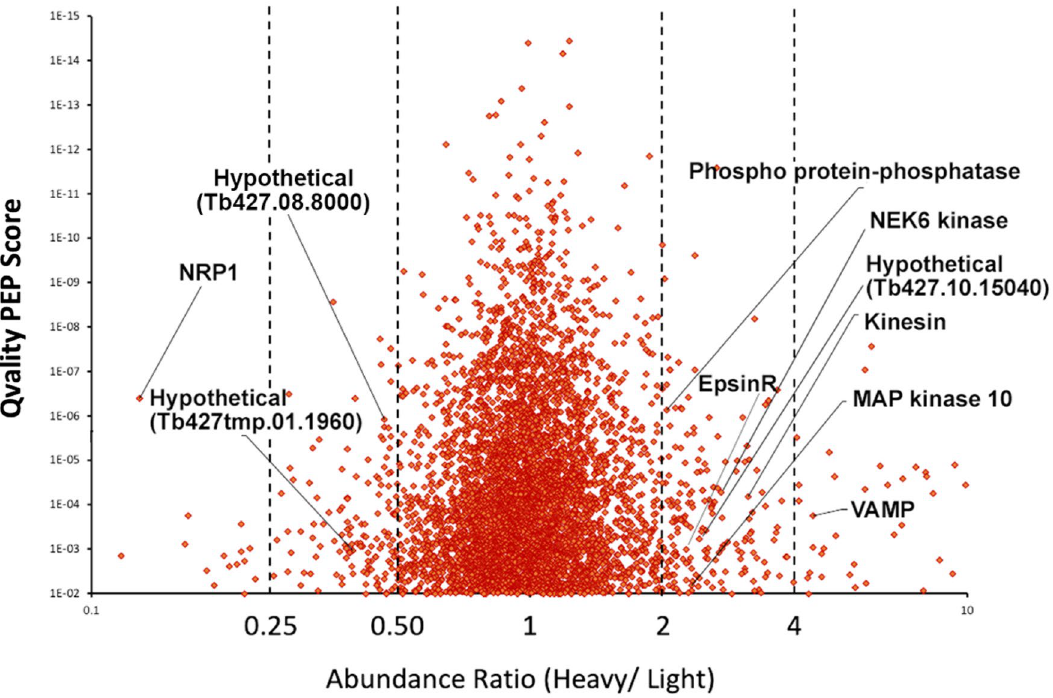
Figure 6. Knockdown of TbNRP1 alters phosphoproteome of T. brucei . TbNRP1-RNAi trypanosomes were labeled in heavy (H) or light (L) HMI-9 SILAC media prior to induction of knockdown with tetracycline 1 ug/mL (Tet+). Twenty-four hours after additional of tetracycline, 4 × 10 7 cells were mixed, lysed, and trypsin digested. Peptides were adsorbed to a SepPak C18 column. Phosphopeptides were enriched by immobilized metal affinity chromatography (IMAC) followed by LC–MS/MS to identify the sequences. Representative